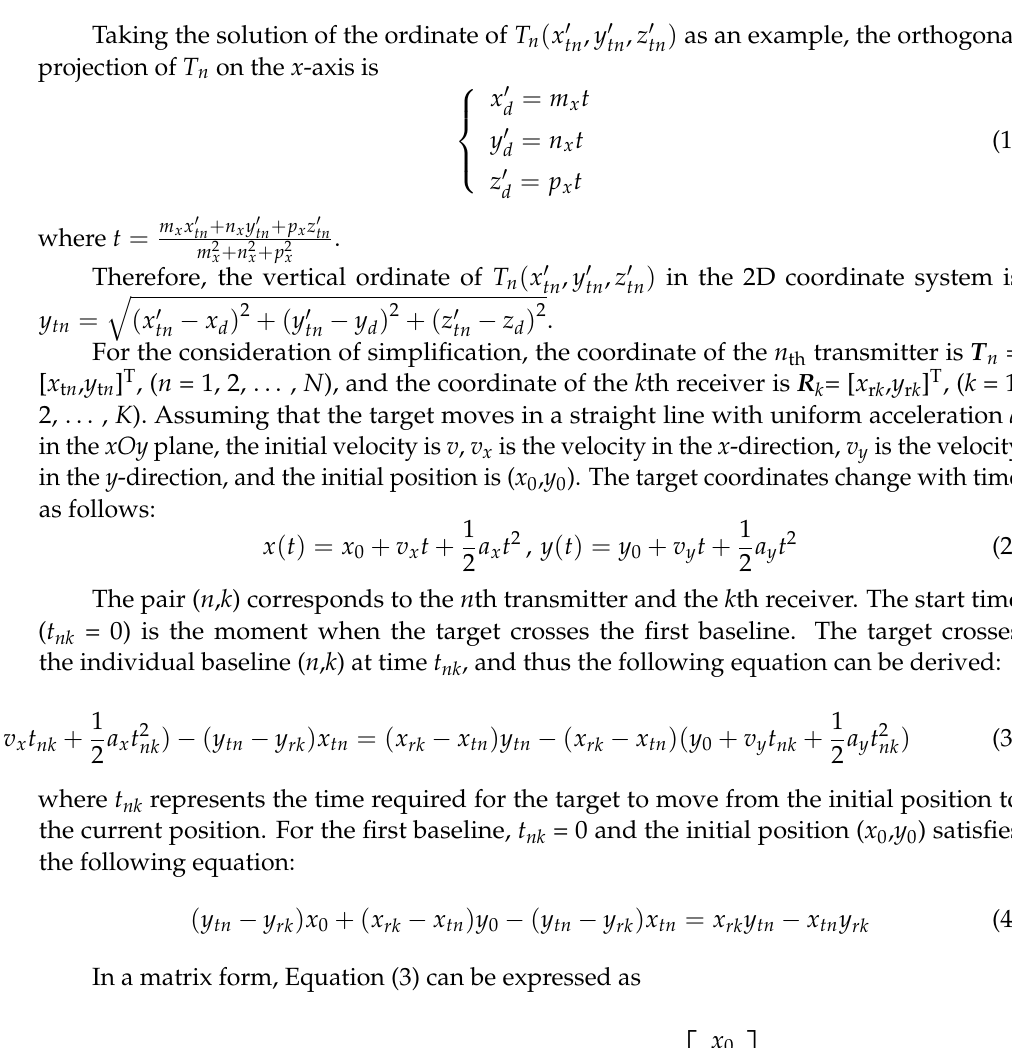
Figure 2. Positioning plane geometry